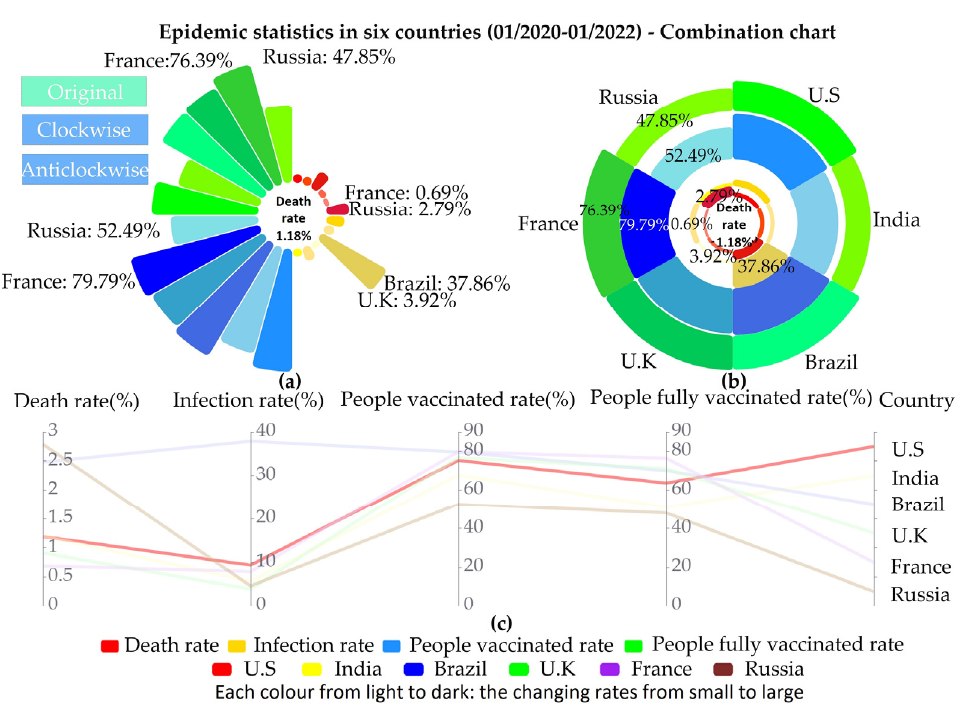
Figure 2. Epidemic statistics in six countries (01/2020–01/2022). ( a ) Multidimensional rose chart. ( b ) Stacked multidimensional rose chart. ( c ) Parallel coordinate chart. Table 1. Death rate, infection rate, vaccination rate and complete vaccination rate in six countries.